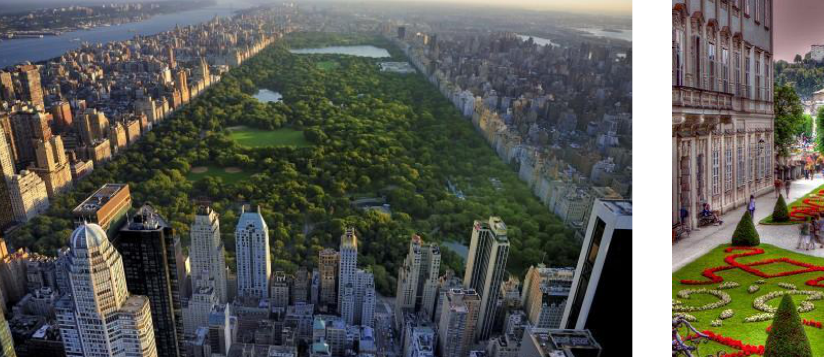
Figure 13. Central park (New York, USA) Figure 14. Mirabell gardens (Salzburg, Austria)